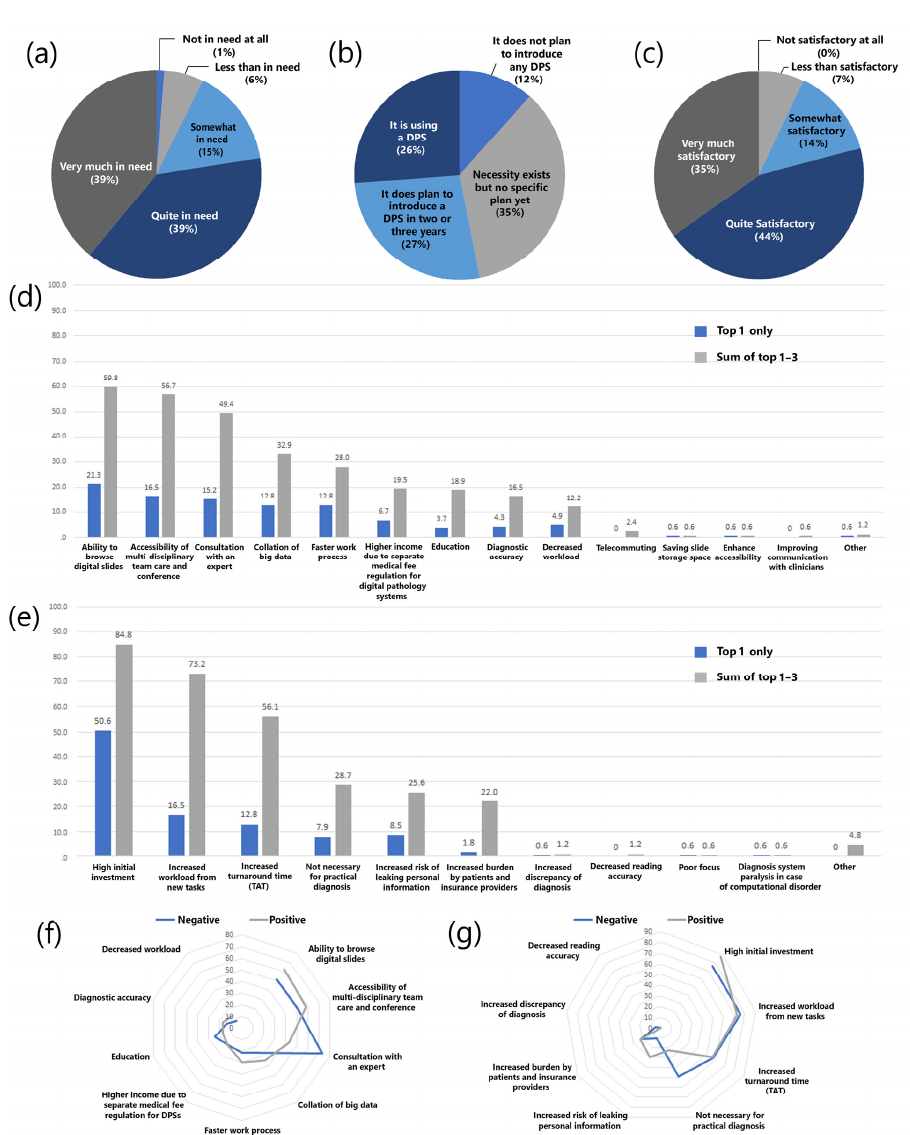
Figure 1. Expectations and concerns regarding digital pathology system (DPS) introduction. ( a ) Recognition of the need to introduce a digital pathology system (DPS). Positive perceptions about the necessity of a DPS accounted for 77.4%. ( b ) Plan to implement a DPS.